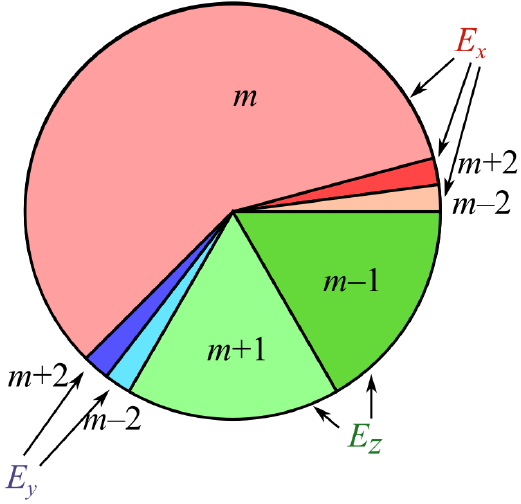
Figure 2. Energy distribution of a tightly focused linearly polarized optical vortex by the field components and by the angular harmonics. Obviously, if the input field is linearly polarized along the axis y , the energy distri ‐ bution is the same, but the main portion (7 W /12, or 58%) goes into the m th ‐ order of the angular harmonic of the y ‐ component E y . The above energy proportions can change if the field intensity is not homogeneous, i.e., if A ( θ ) ≠ 1. However, if the amplitude function A ( θ ) decays from the center to the periphery, then the contribution of the m th ‐ order angular harmonic becomes even greater. Indeed, for instance, if the aperture is bounded by an angle α , then the energy of the side angular harmonics of the orders m + 2 and m − 2 relative to the energy of the cen ‐ tral m th ‐ order harmonic is